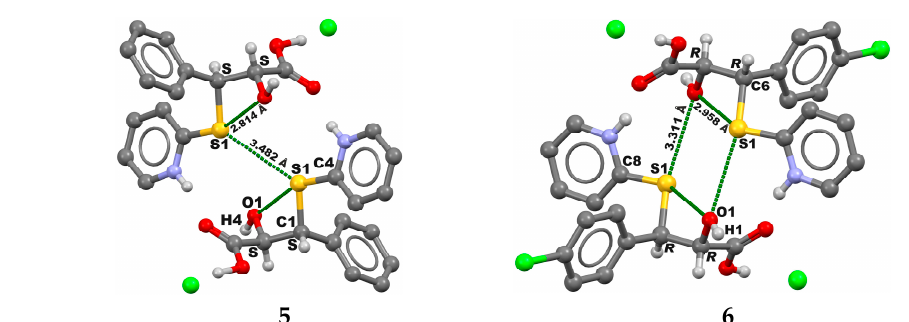
Figure 1. X-ray structure of 1 , 5 , and 6 .